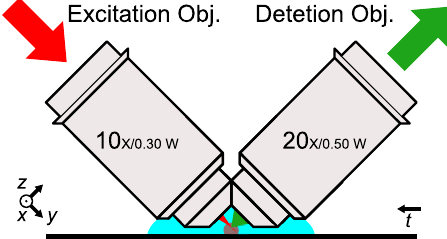
Figure 1. The iSPIM geometry of light sheet microscopy used in this paper allows to image tissue samples mounted on standard microscope slides. The xyz coordinate system used throughout this paper is defined as relative to the detection objective, the t -axis represents translation